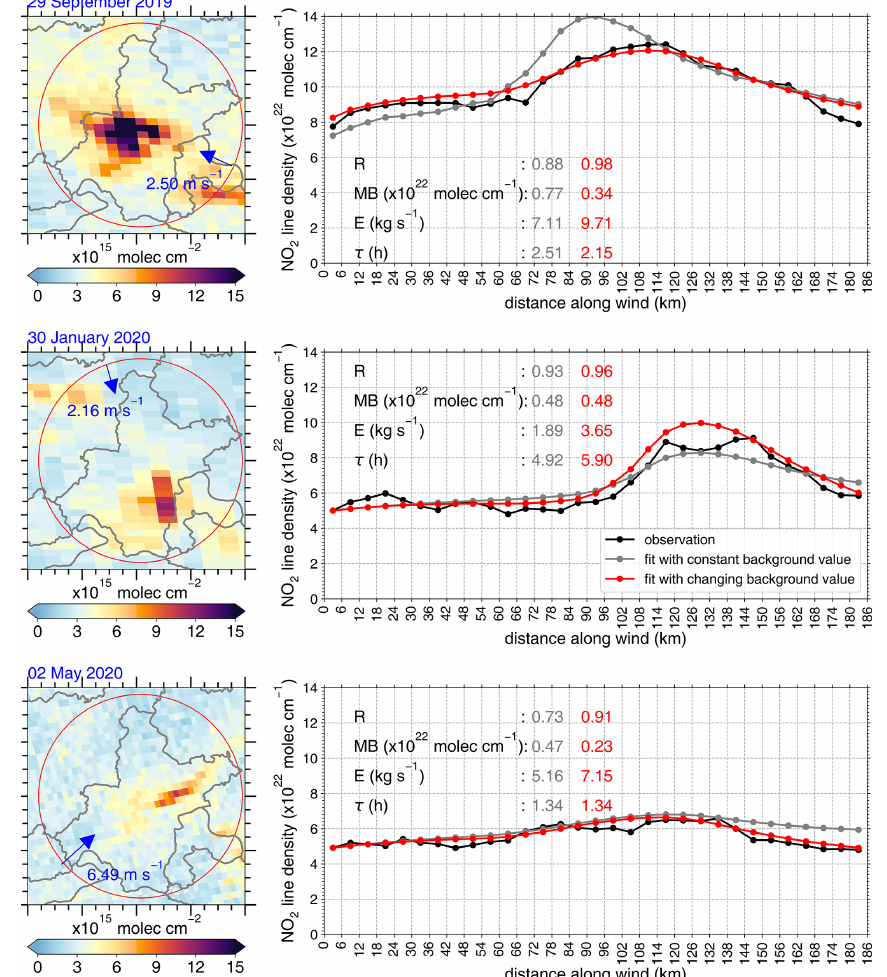
Figure 1. Tropospheric NO 2 columns over Wuhan on 29 September 2019, 30 January 2020 and 2 May 2020 (left panels, from top to bottom); the red circle inside each map defines the study domain. The corresponding NO 2 line densities along wind within the study domain are given in the right panel. For each day, the correlation coefficient ( R ) between the observed (black line) and fitted (grey and red lines) NO 2 line density is given. The fitted mean bias (MB), NO x emissions ( E ) and NO x lifetime ( τ ) are also